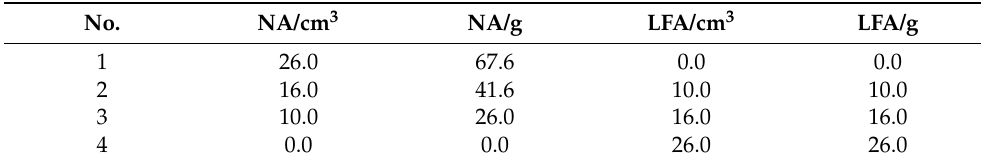
Table 3. Aggregate configuration scheme of anode cells of the simulated ICCP